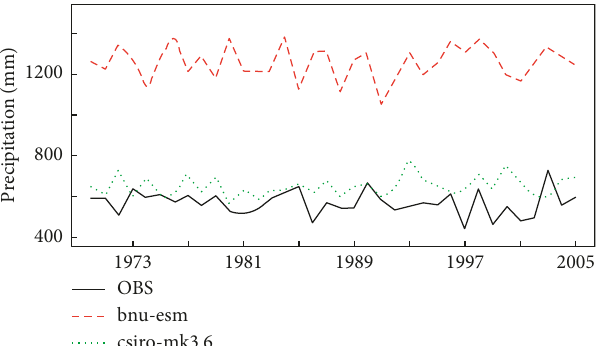
Figure 9: Annual precipitation changes in the Yellow-Huai-Hai